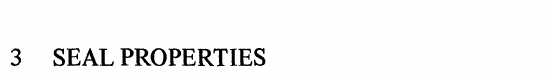
FIGURE 2 Effect of surface roughness on tensile strength of Kovar #7052 bonds.